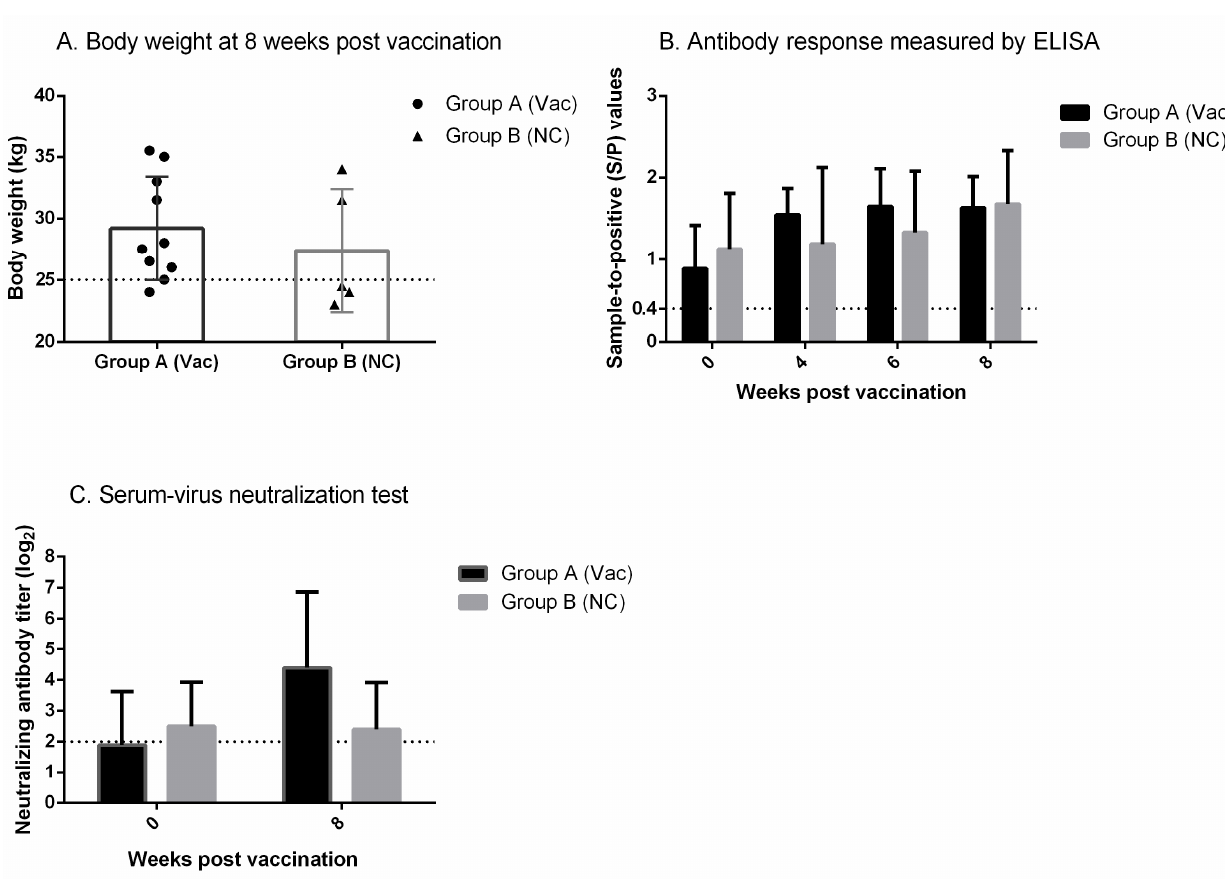
Figure 3. Results of the animal experiment: vaccine performance under field conditions. A farrow-to-finisher farm infected with PRRSV-2, KU-PRRSV-2020-002, was selected for the animal experiment. A total of 15 three-week-old piglets were randomly divided into groups A and B, which consisted of 10 and 5 pigs, respectively. Group A was immunized intramuscularly (IM) with the vCSL1-GP5-N33D inactivated vaccine (10 7.0 TCID 50 /1 mL/dose), while group B was injected IM with PBS as